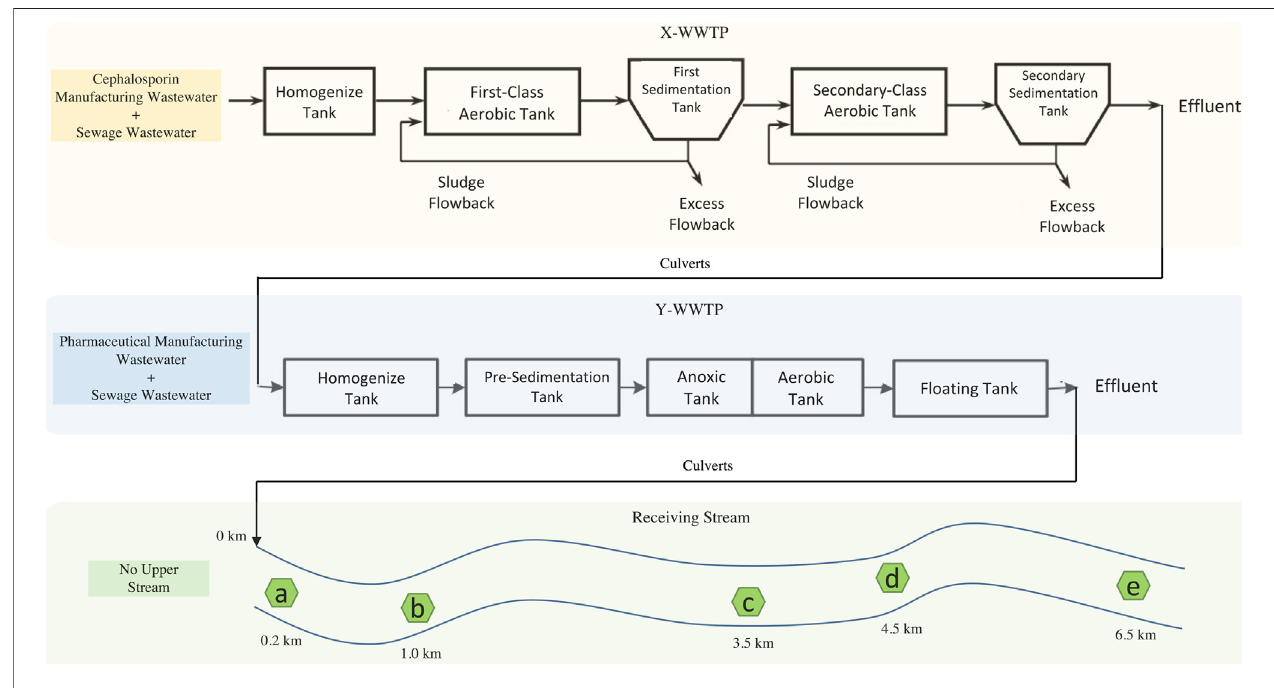
FIGURE 1 | Sampling map.